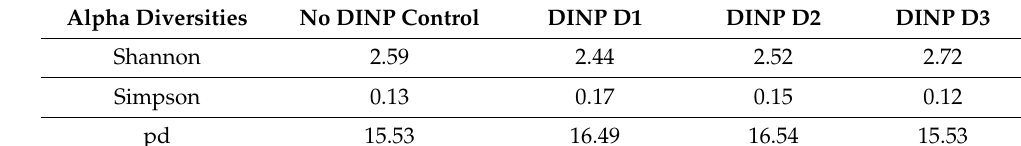
Table 2. Alpha diversity indices of resultant fermenter microbiota in DINP experiment.